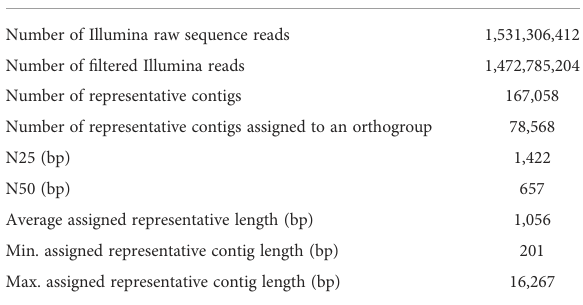
TABLE 1 Trinity assembly statistics for the combine transcriptome of the 27 samples of B. oldhamii ‘ Xia Zao ’ .